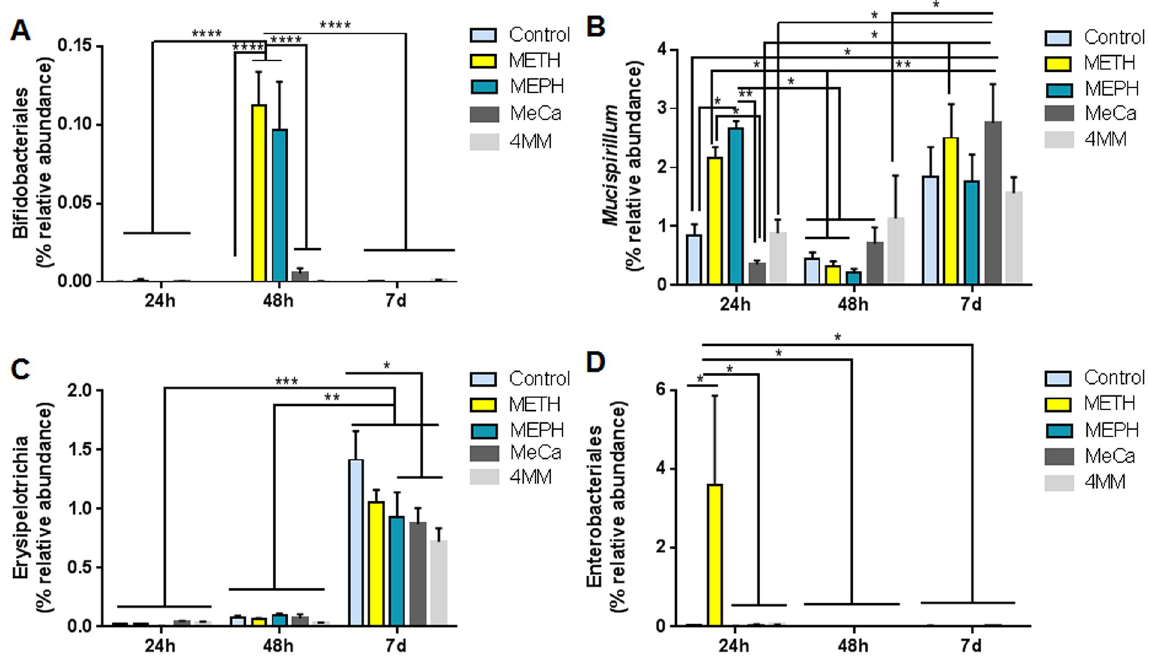
Fig 6. Effects of study drugs on selected taxa below the level of phylum. Results are presented as % relative abundance of taxa 1, 2 or 7 days after drug injections for Bifidobacteriales (A), Mucispirillum (B), Erysipelotrichia (C) and Enterobacteriales (D). � p < 0.05, �� p < 0.01, ��� p < 0.001 and ���� p < 0.0001 for the comparisons demarked by connecting lines above the bars.